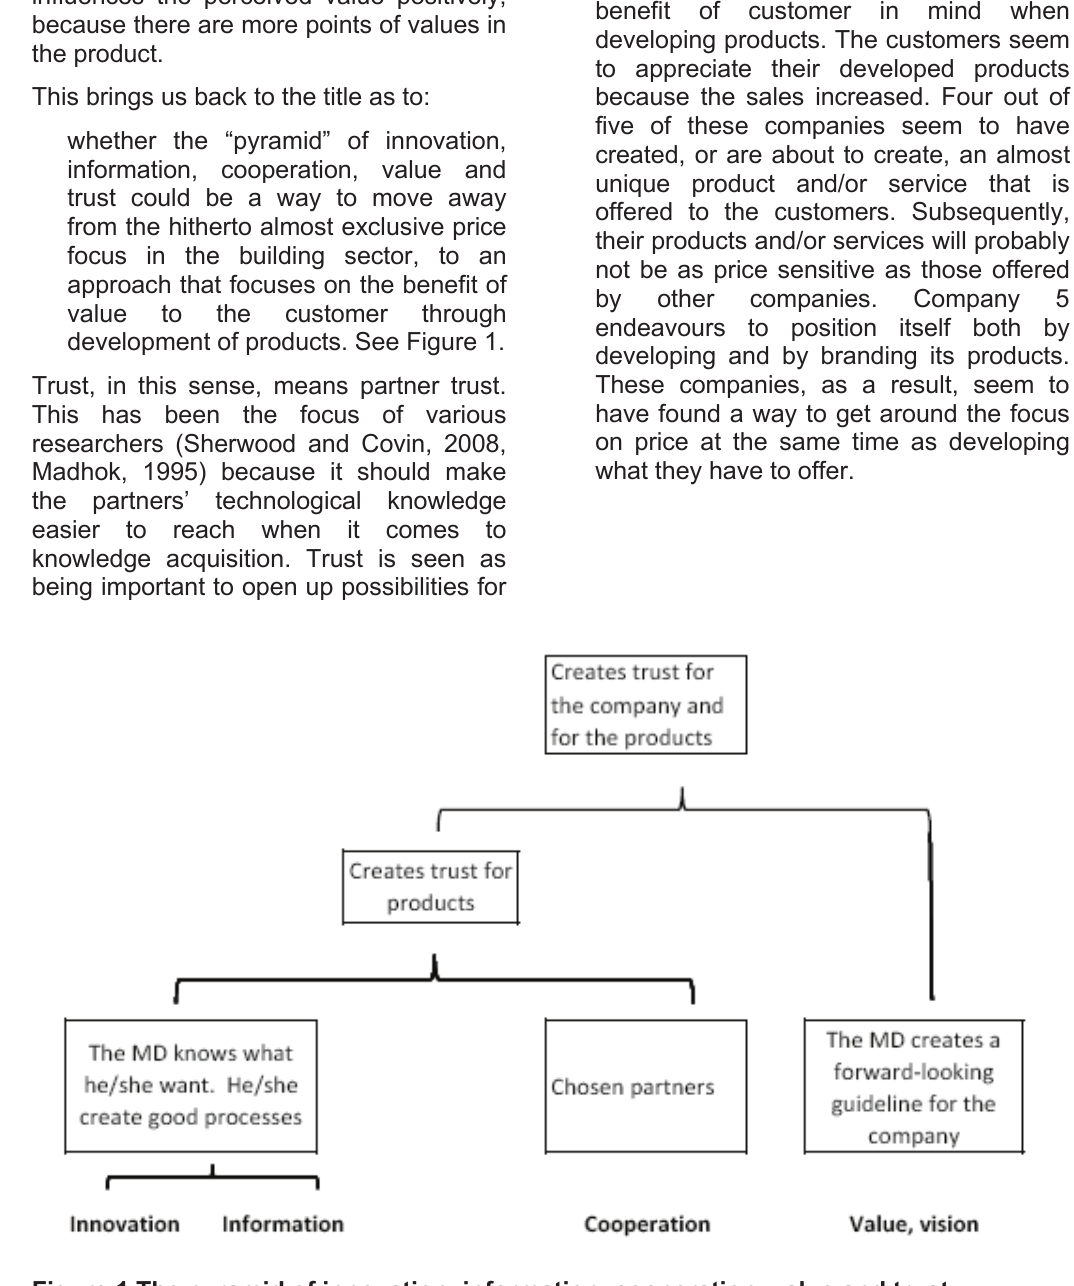
Figure 1 The pyramid of innovation, information, cooperation, value and